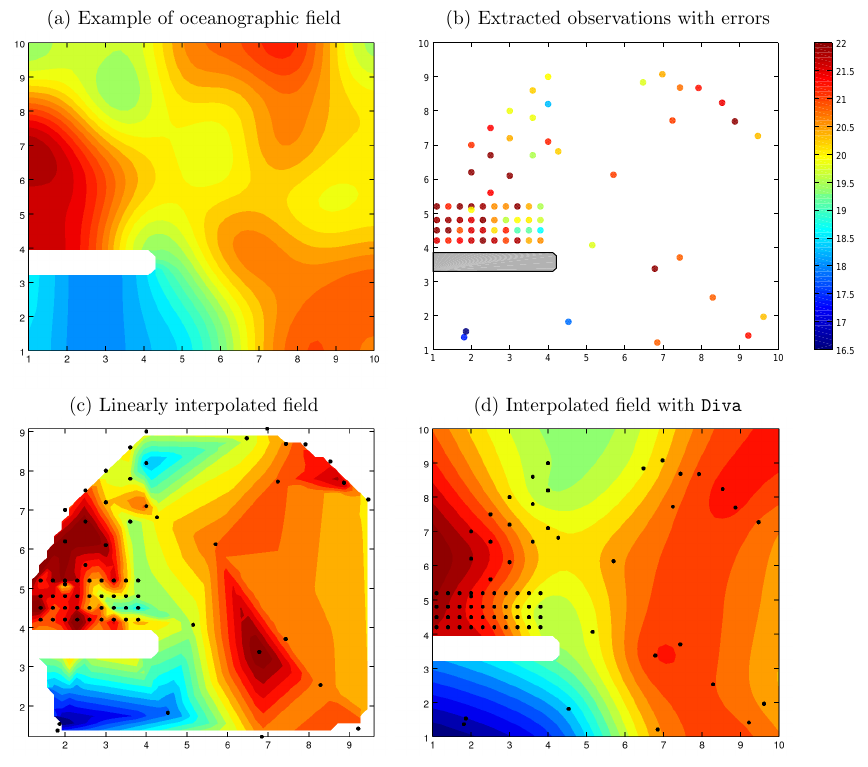
Fig. 1. Reconstruction of a field based on scattered observations using linear interpolation and DIVA. information on one side of the barrier, affects the interpolated fields on the other